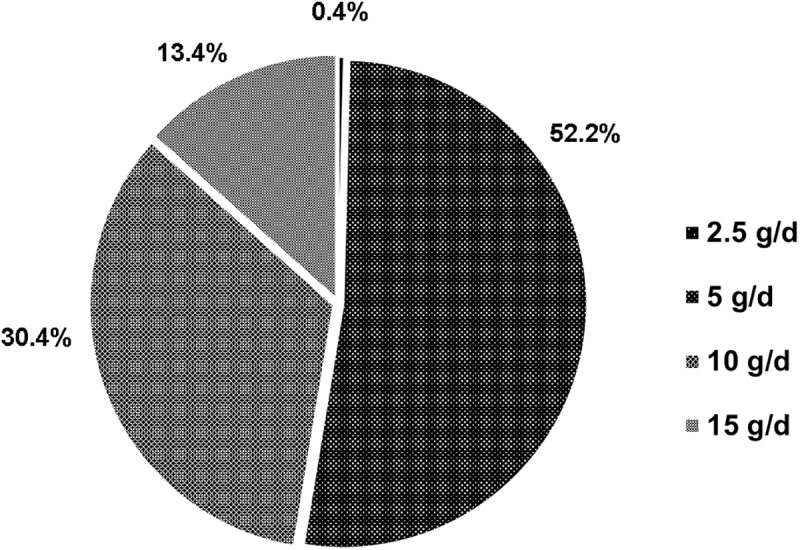
Dosage distribution for the use of calcium polystyrene sulfonate.